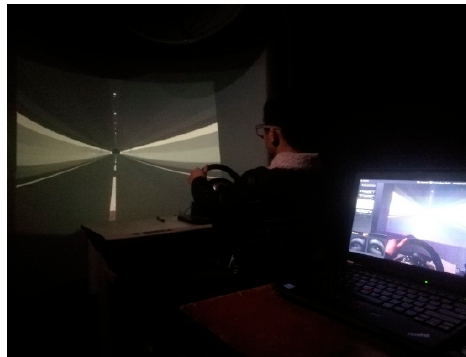
Figure 4. Test process. Figure 4. Test